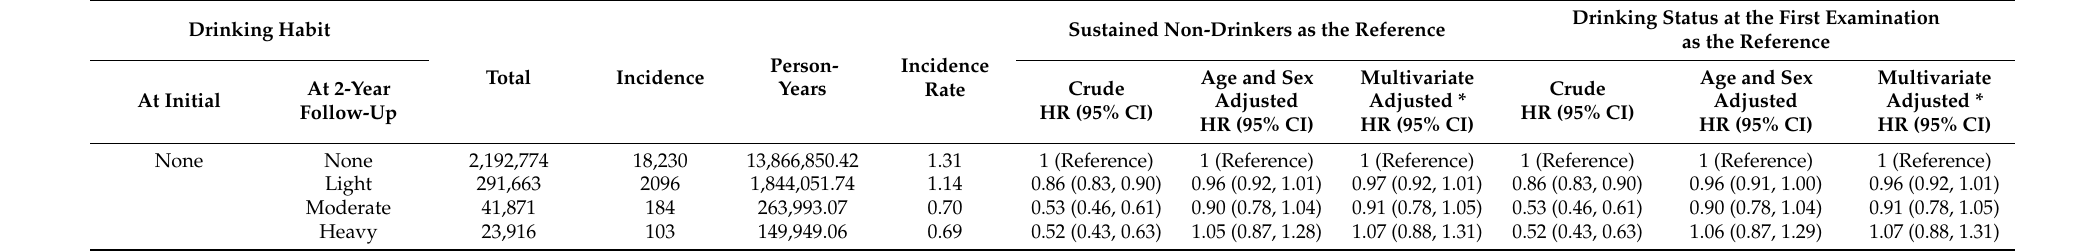
Table 3. Changes in alcohol intake and thyroid cancer